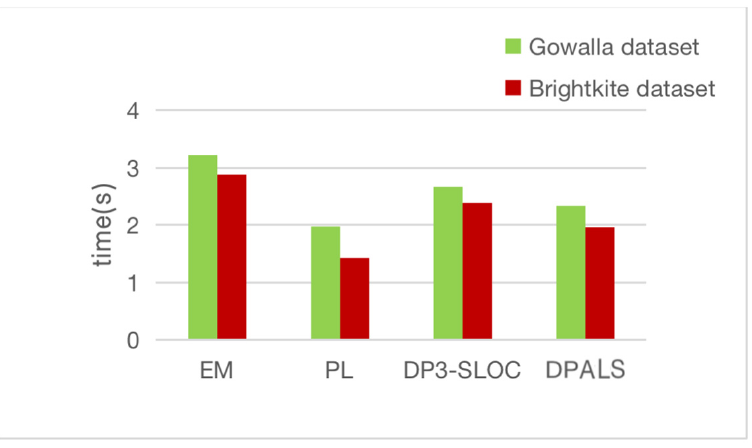
Figure 9. Computational overhead of the four protection mechanisms on the two datasets.